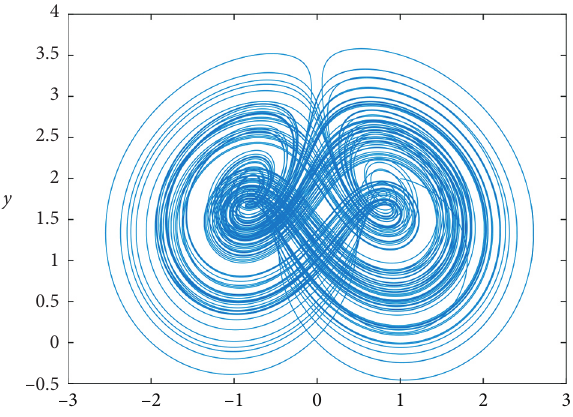
Figure 21: Dynamic behavior of fractional financial chaotic model with α � 0 .